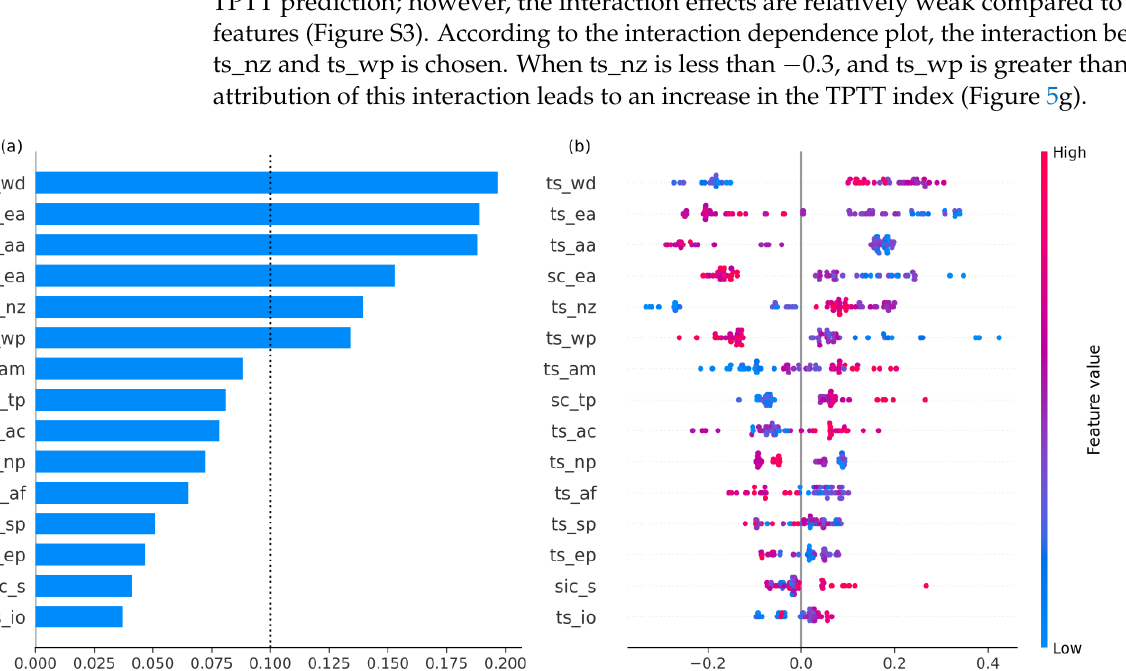
Figure 5. The dependence plots of six important features ( a – f ). The interaction dependence plot of ts_wp and ts_nz ( g ). The dots indicate the samples.